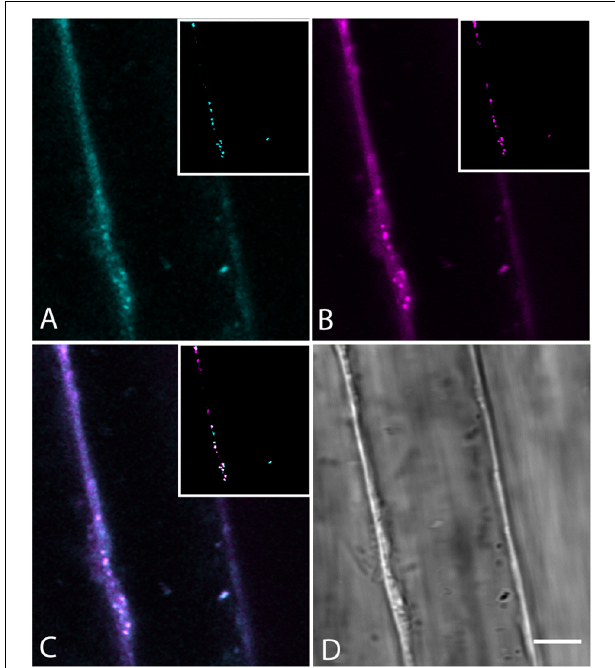
FIGURE 10 | Colocalization of BCh in Nile Red-labeled oil bodies in elongating root cells labeled for 30 min with both probes. (A) Fluorescence of BCh at the PM and in the cytoplasm. The inset is a cyan binary mask of the brightest organelles in the image ( > 128 of 256 gray levels) in the region of the cell shown. (B) Fluorescence of Nile Red at the PM and cytoplasm. The inset is a magenta binary mask of the brightest organelles in the image ( > 128 of 256 gray levels) in the region of the cell shown and marks the oil bodies. (C) Merged image of (A and B) , where the inset is a composite mask of the insets in (A and B) , showing that the majority of bright organelles are white, or colocalized. (D) Bright-field micrograph of the cell. Scale bar = 5 µ m.